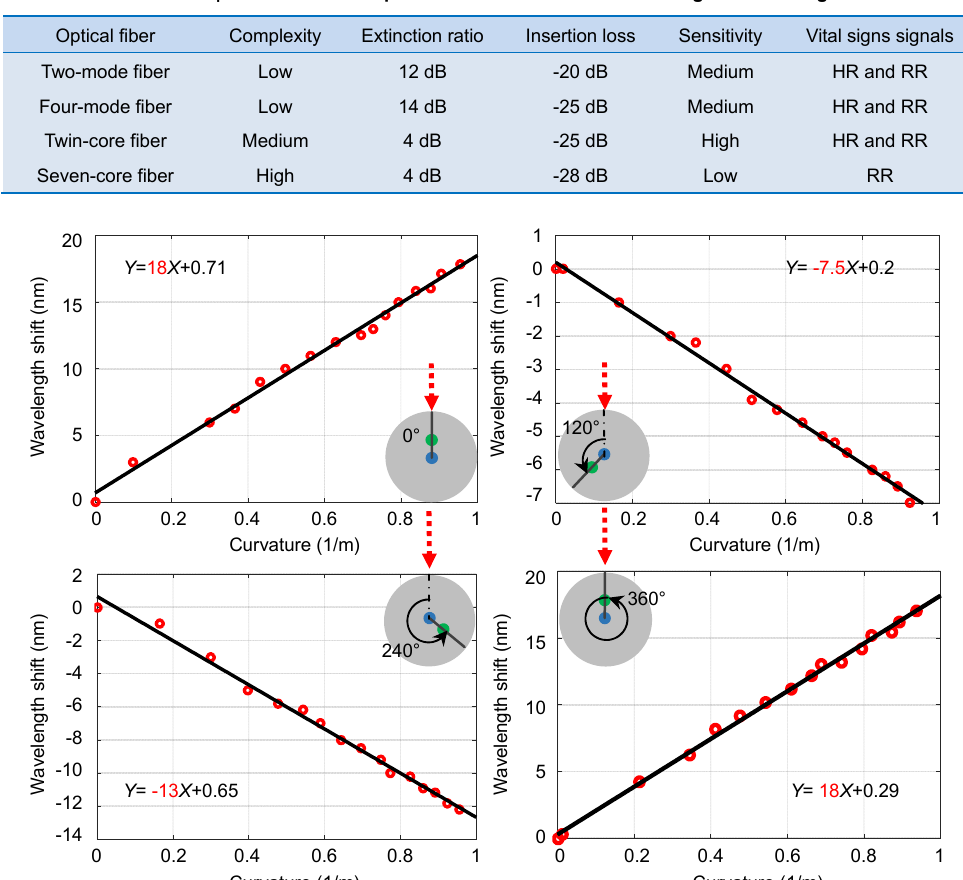
Fig. 13 | Curvature sensing results based on the TCF in-line interferometer: different sensitivities are observed under different bending direction from 0 o to 360 o , for example the wavelength shift results under the curvature from 0 m -1 to 1 m -1 indicates the sensitivity of 18 nm/m -1 under the orientation angle of 0 o